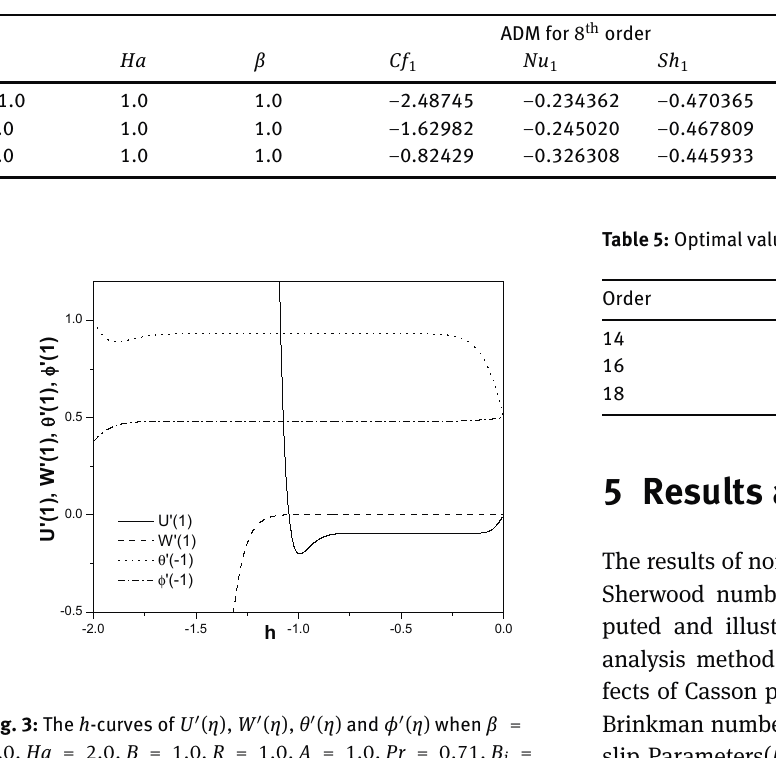
Fig. 3: The h -curves of U (cid:2) ( η ), W (cid:2) ( η ), θ (cid:2) ( η ) and ϕ (cid:2) ( η ) when β = 1.0, Ha = 2.0, B = 1.0, R = 1.0, A = 1.0, Pr = 0.71, B i = 2.0, Sc = 0.22, B h = 2.0, Sr = 0.3, Br = 0.5